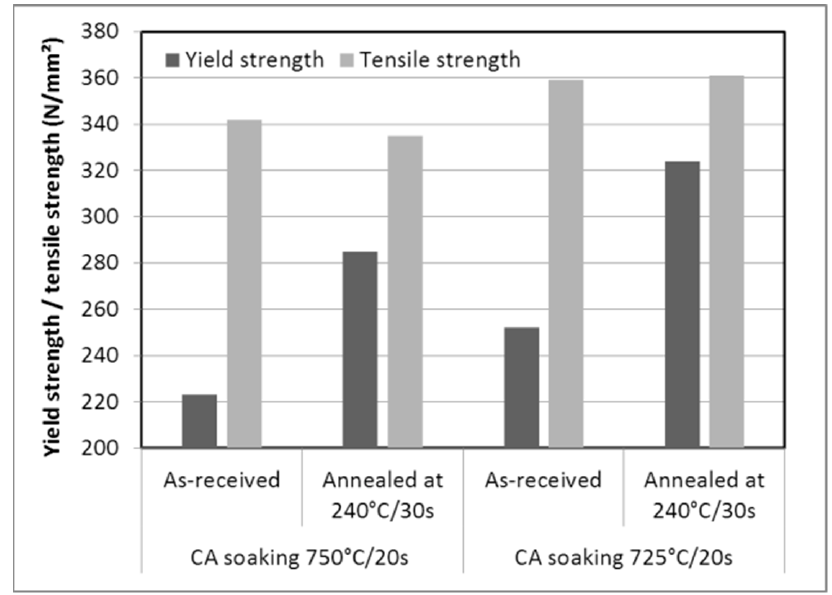
Figure 5. The effect of CA soaking temperature on tensile properties.